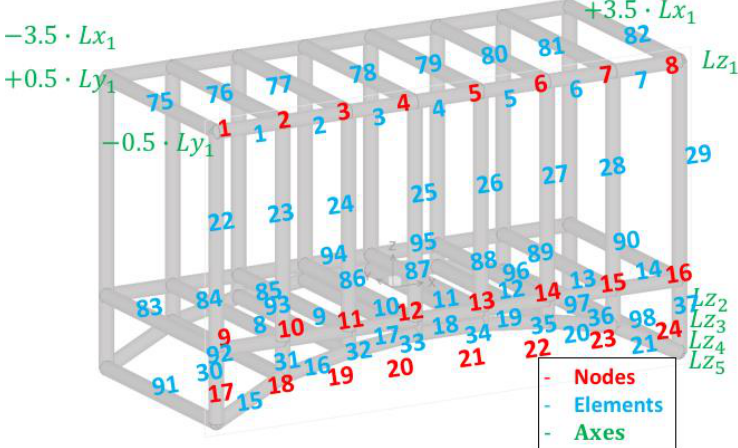
Figure 5. Finite element model nodes, elements and axes.